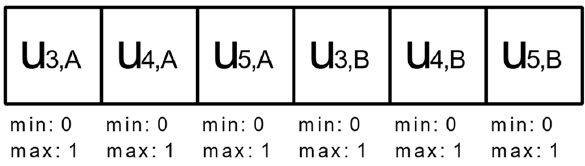
Figure 21. Strategy #5 chromosomal structure.